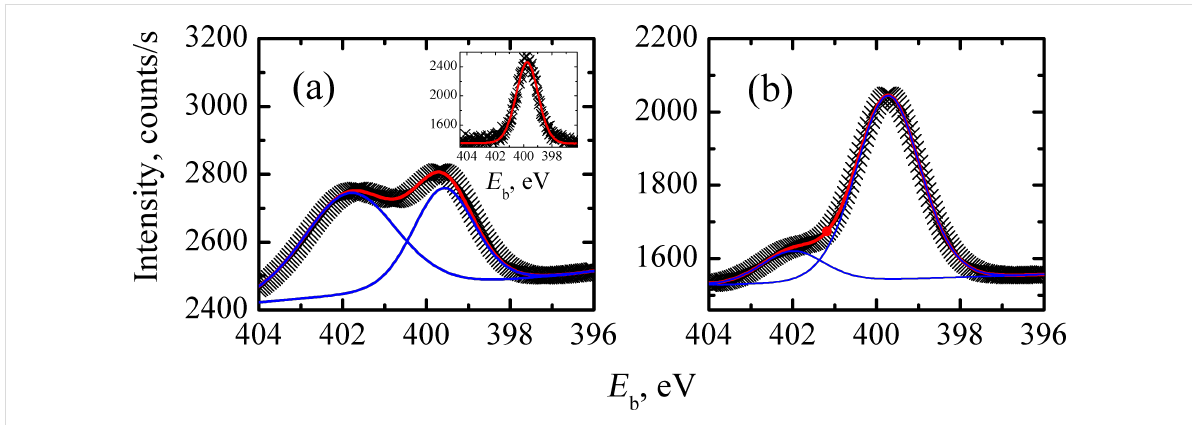
Figure 10: High-resolution N 1s XPS spectra of samples on SiO 2 /Si substrate. (a) Raw data for sample A (black crosses). The blue line is the result of the fitting procedure and the red line corresponds to the envelope of the fitted peaks. Inset: N 1s XPS spectrum of a bare substrate (black symbols) together with the fitting curve (red). (b) Raw data for sample B (black crosses). The blue lines are the result of the fitting procedure and the red line corresponds to the envelope of the fitted